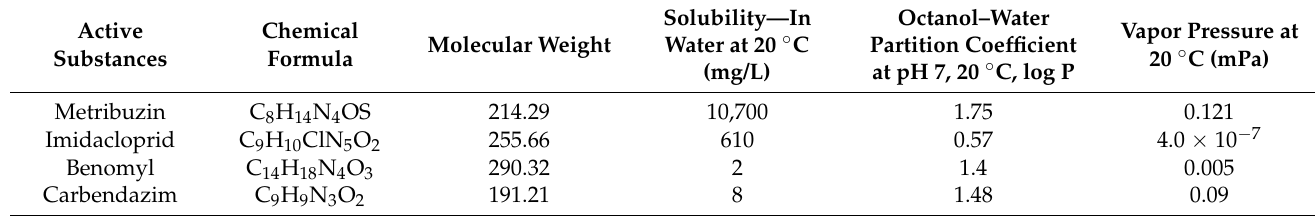
Table 1. Physical/Chemical Properties of pesticides.